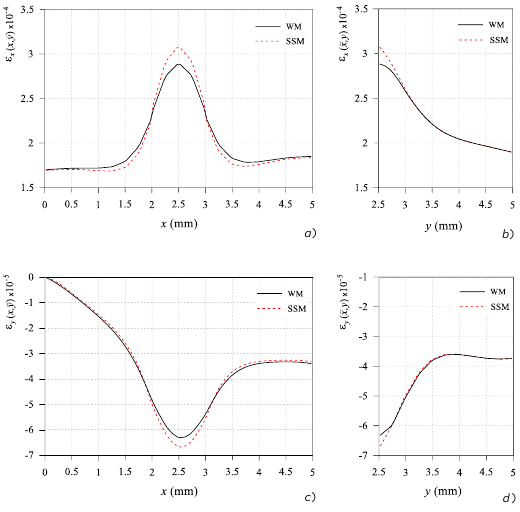
Figure 2. Nonlocal elastic symmetric square plate under tension. Strain components profiles 𝜀 𝑥 and 𝜀 𝑦 versus x at 𝑦≅2.5 on the left side and versus y at 𝑥≅2.5 on the right side. Solutions computed on the whole model (WM) of the plate (solid lines); solutions computed on the (half-structure) standard symmetric model (SSM) of the plate (dash lines).